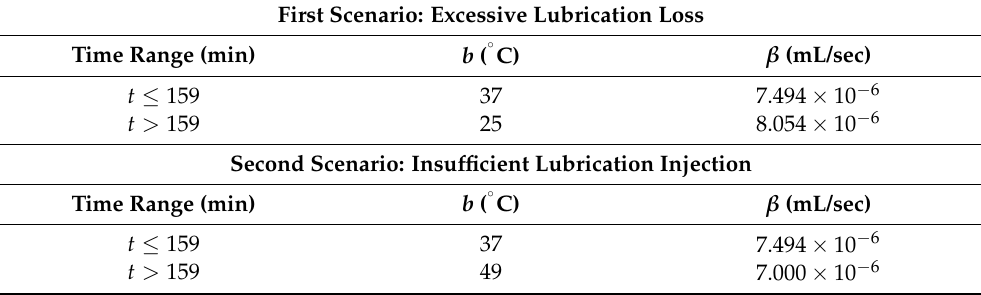
Table 4. Fault scenarios for prognostics evaluation.